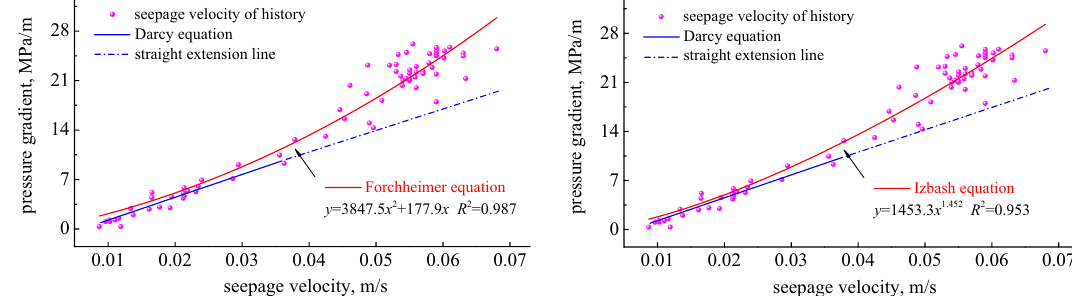
Figure 5. Comparison of historical data with the calculated result of the Darcy and non-Darcian flow